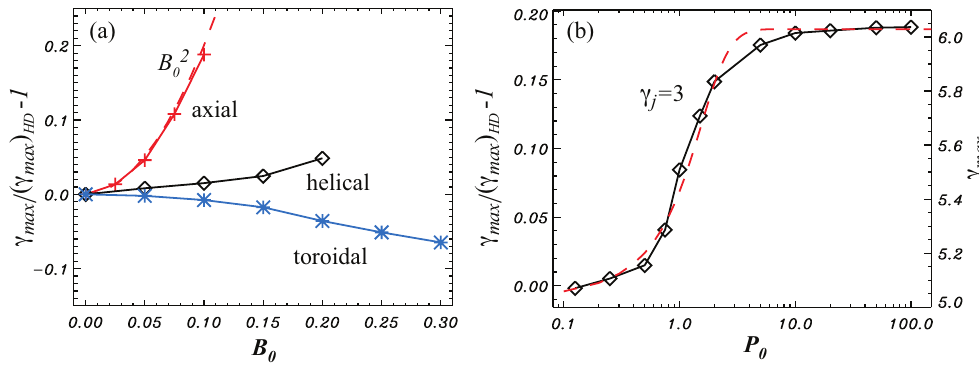
Figure 3. Left panel: Dependence of the relative difference of the maximum Lorentz factor relative to the purely hydrodynamic case γ max / ( γ max ) HD − 1. All quantities are shown as a function of the initial magnetic field strength B 0 in the case of axial (red crosses), toroidal (blue stars), and helical magnetic fields (black diamonds) with initial magnetic pitch P 0 = 0.5. The red dashed line indicates a quadratic fit. Right panel: Dependence of the maximum Lorentz factor γ max (right vertical axis) and relative difference of the maximum Lorentz factor relative to the purely hydrodynamic case γ max / ( γ max ) HD − 1 (left vertical axis) as a function of the initial magnetic pitch P 0 . The initial jet Lorentz is set to γ j = 3. The red dashed line indicates the fitting with a hyperbolic tangent function. Figure taken from